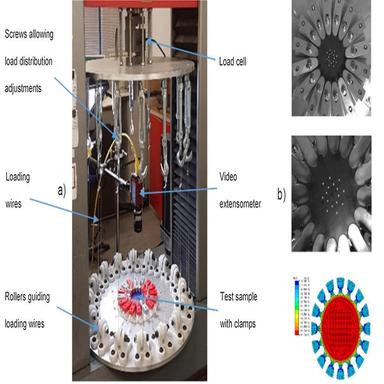
a) Equi-biaxial test rig, b) Stretching of Equi-biaxial sample in this study, and FEA validation of sample performed by Day, J. (reproduced from).